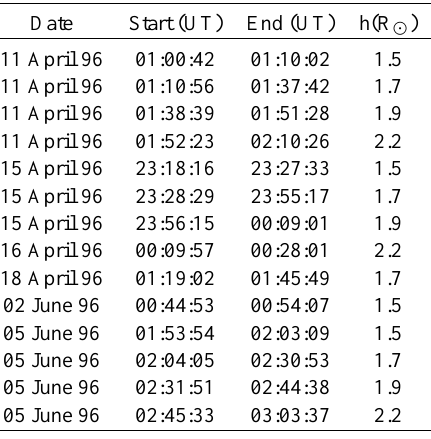
Table 1. Quiescent streamers used in the